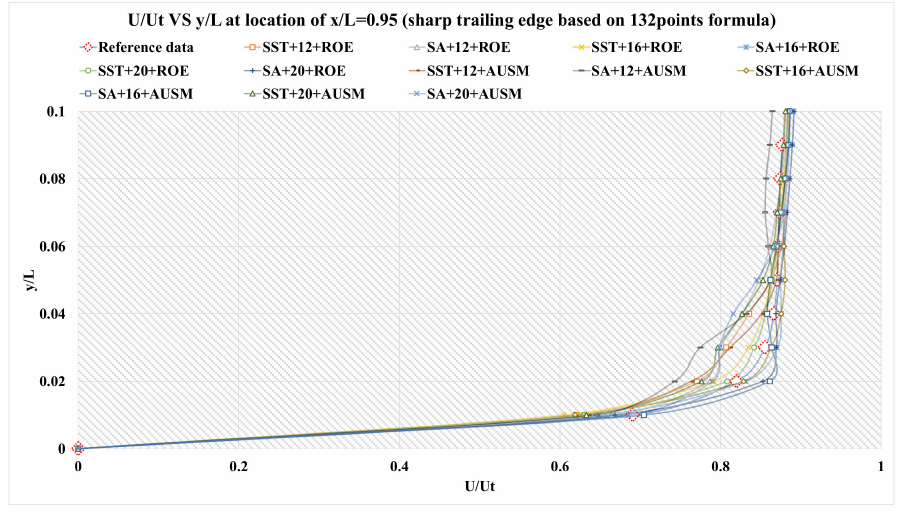
Figure 12. Distributions of U/U t of the sharp trailing edge based on 132 points formula at location of x/L = 0.95. Table 14. The mean error ratios of P/P t , T/T t , and U/U t of the sharp trailing edge based on 132